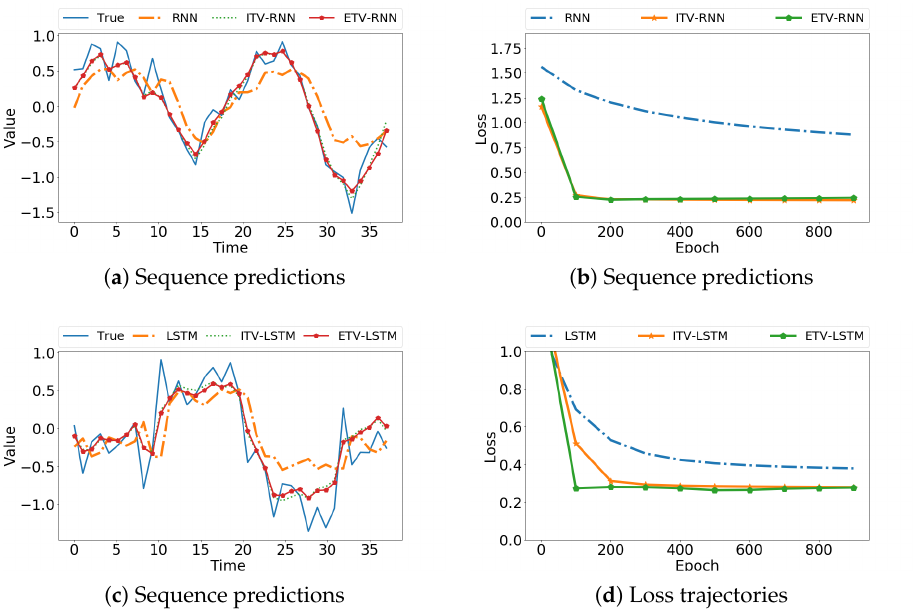
Figure 4. Prediction of noisy simulation data (Gaussian noise, N ( 0,0.5 ) ) using the original model, ITV, and ETV,